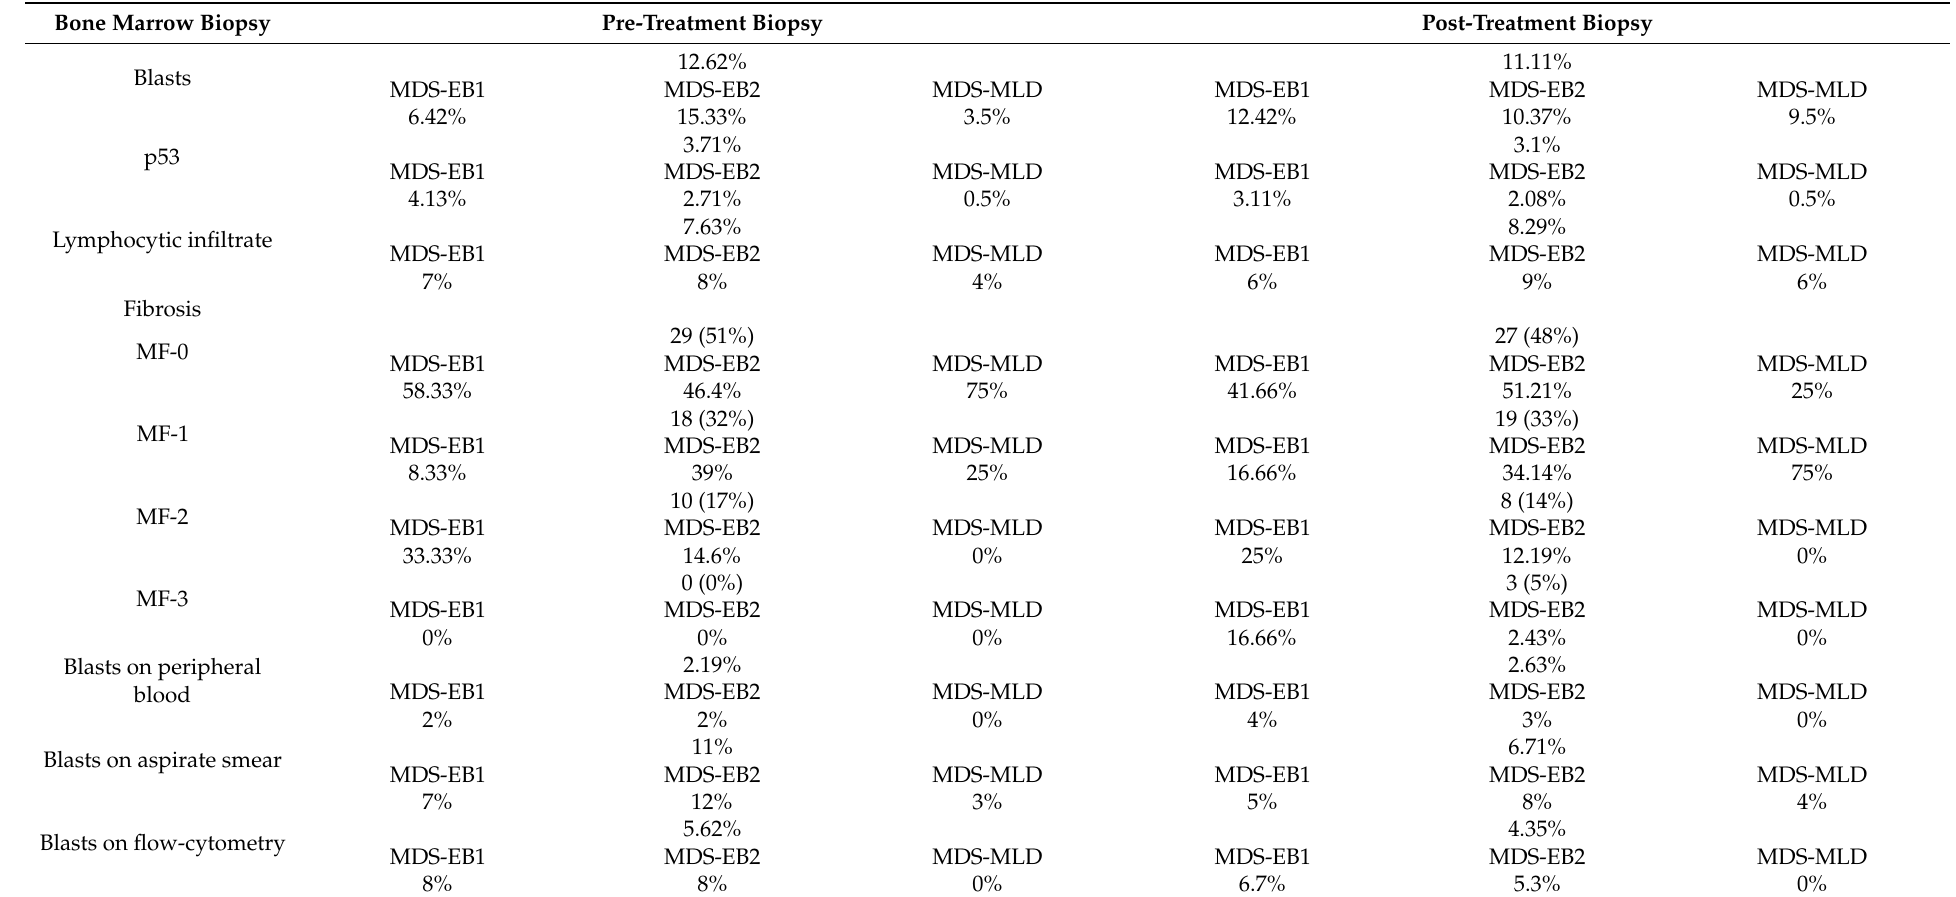
Table 2. Comparison between pre- and post-treatment evaluation: blasts on bone marrow and detected on peripheral blood, aspirate smear and flow-cytometric, and other variables detected on bone marrow